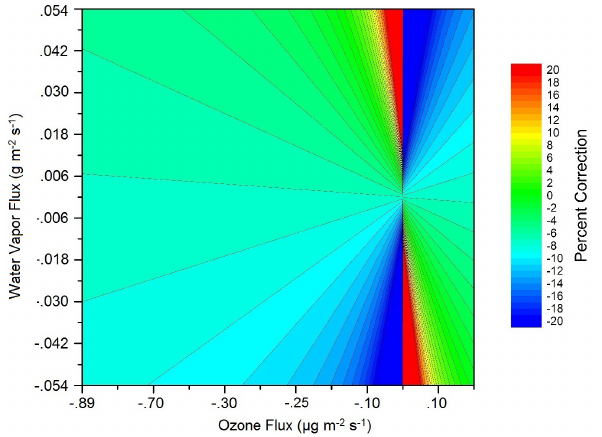
Fig. 1. Isopleths of the correction to be applied to the measured ozone flux as a function of water vapor flux using typical values for ambient-air water vapor and ozone mole fraction over the ocean, i.e. 40nmolmol − 1 of ozone and 18mmolmol − 1 of water vapor. The solid lines represent 1% increments in the correction. When the ozone fluxes and water vapor fluxes are in the same direction, the measured ozone flux has a positive error, as seen in the nega- tive correction factor to be applied to quadrants 1 and 3. When the ozone flux and water vapor flux are in opposite directions, there is a negative error, requiring a positive correction of the measured ozone flux, as seen in quadrants 2 and